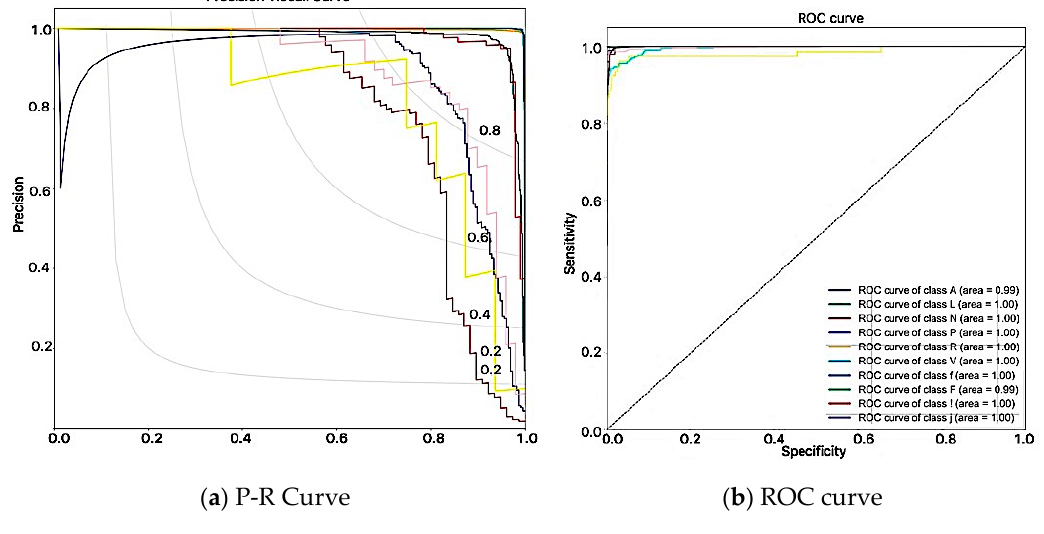
Figure 6. Classifier performances.